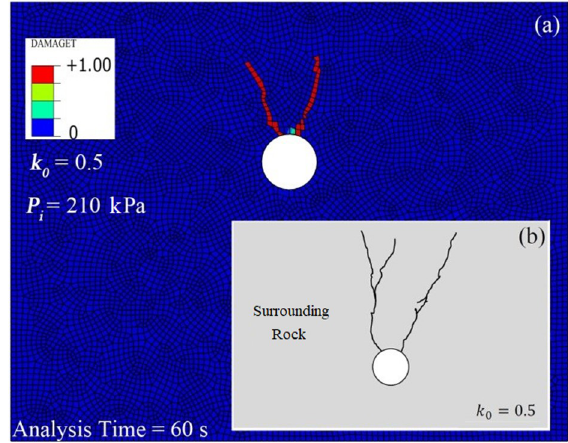
Figure 5. Comparing the formation and location of cracks in the numerical model ( a ) vs. the experimental model by Tunsakul et al. (2014) ( b ).